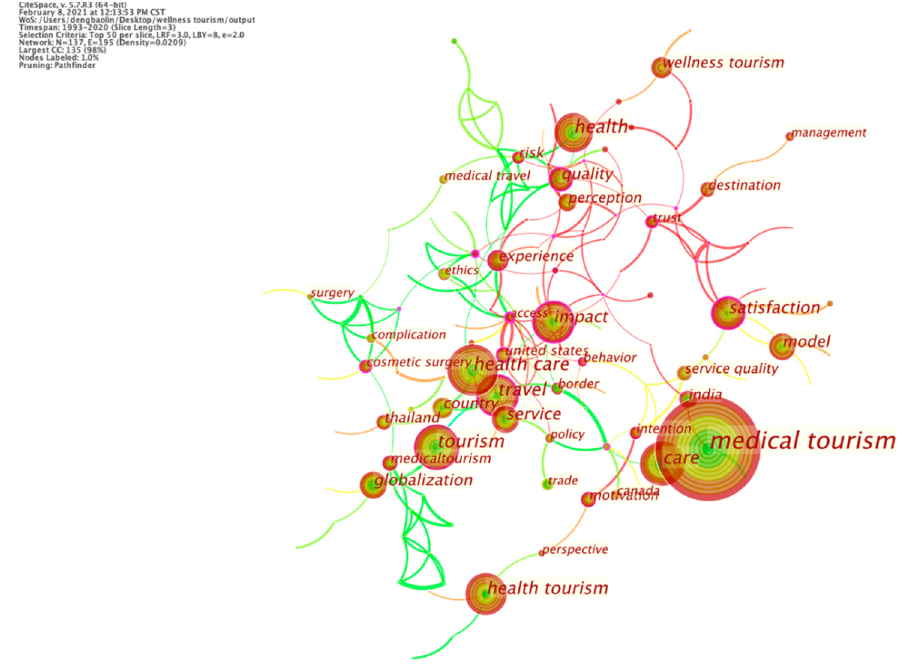
Figure 5. Frequencies of research keywords.